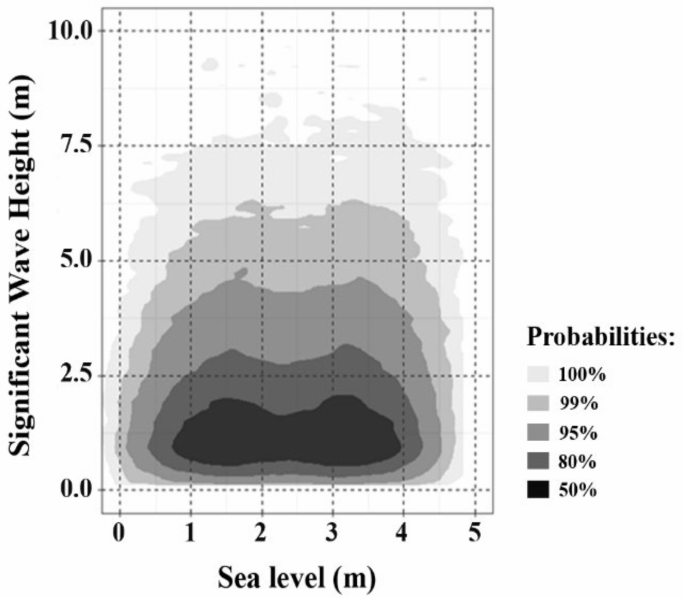
Figure 12. Joint probabilities of the significant wave height and sea level in the Eastern Cantabrian Sea from 1996 to